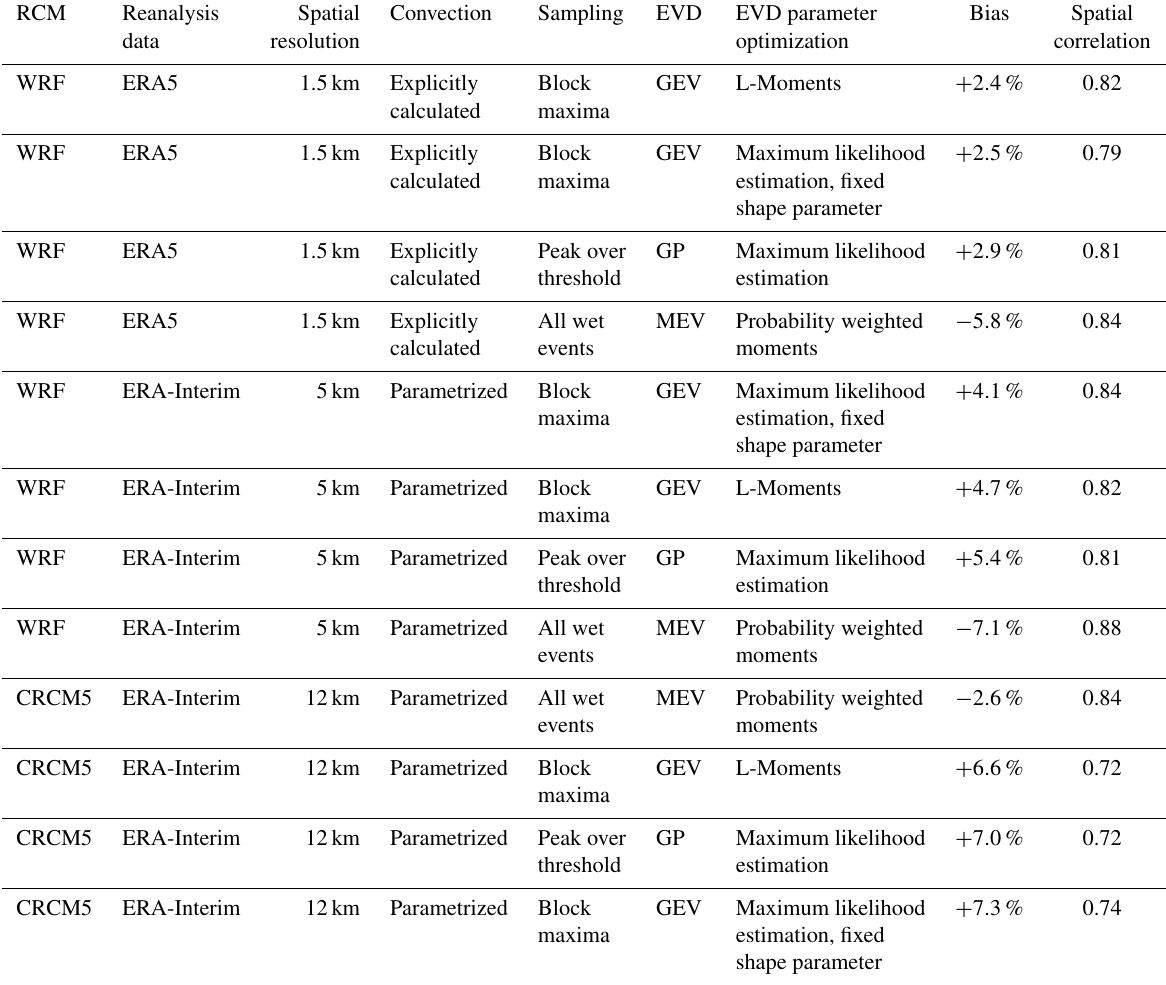
Table 2. Summary of the applied RCM setups and EVT approaches. Performance metrics of the comparison to observational 10-year return levels are given in terms of the spatially averaged bias and spatial correlation (Spearman). The entries are sorted first by resolution and then by amount of